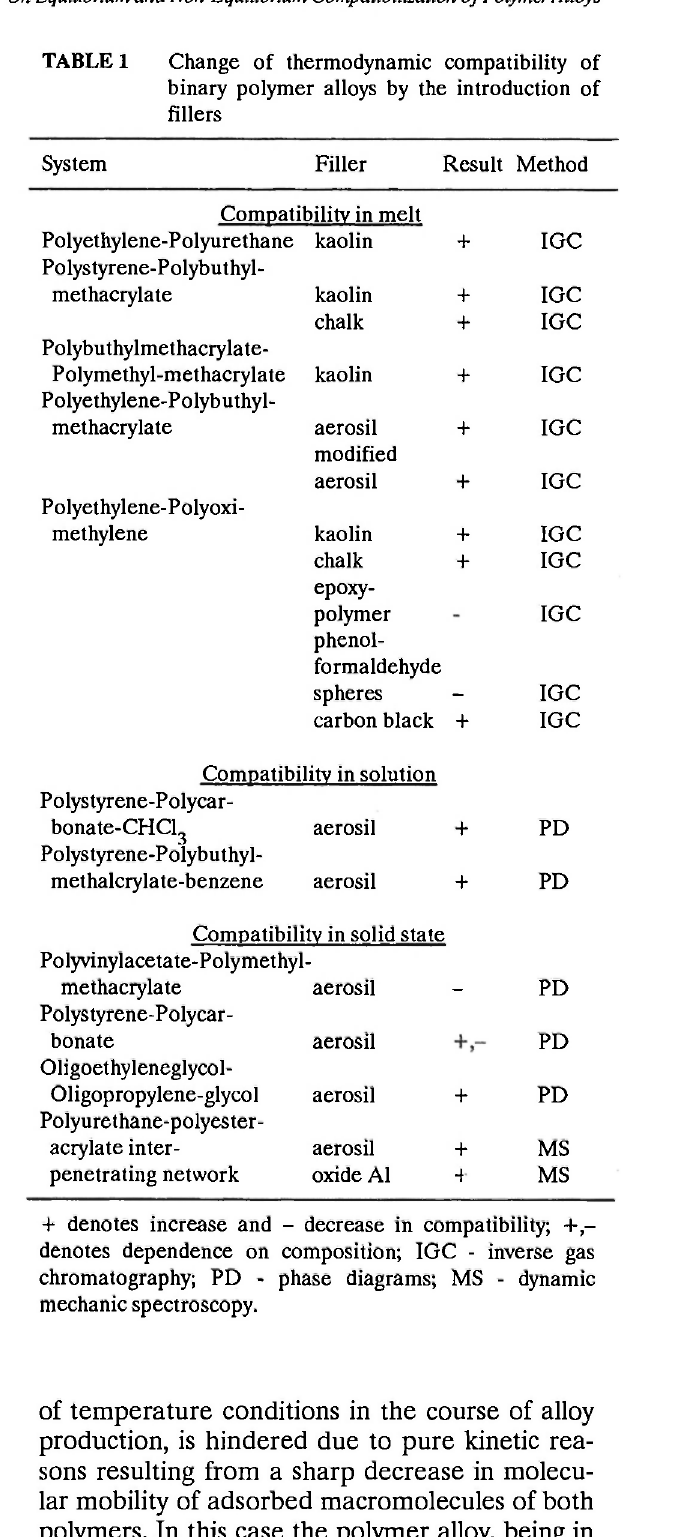
Change of thermodynamic compatibility of binary polymer alloys by the introduction